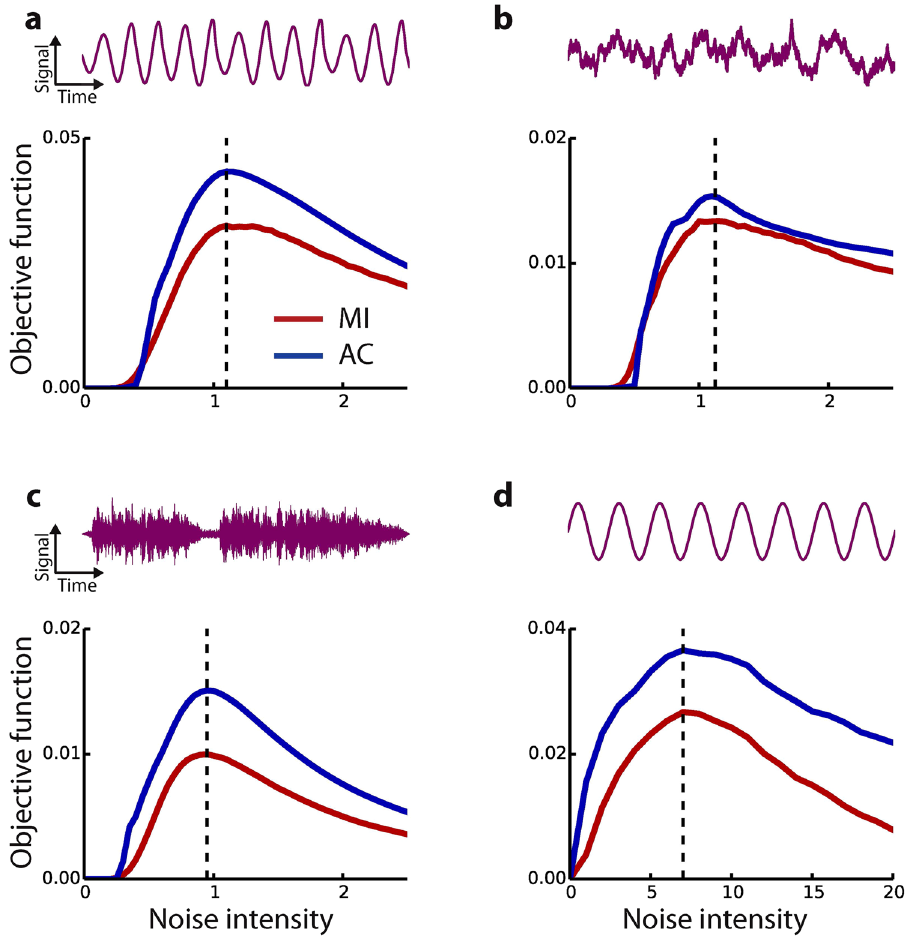
Figure 4. Performance of the output autocorrelation method. Comparison of resonance curves using the mutual information (red) and the output autocorrelation (blue) for different continuous signals. ( a ) Projection of the 3-dimensional Roessler attractor in one dimension, asymmetric threshold. ( b ) Ornstein-Uhlenbeck process, symmetric threshold. ( c ) Wave files of recorded speech, music and natural sounds, symmetric threshold. The biologically important case of the leaky integrate-and-fire model is shown in ( d ) with sine wave with constant frequency and amplitude as input. The signal-to-threshold distance was 0.1 for all